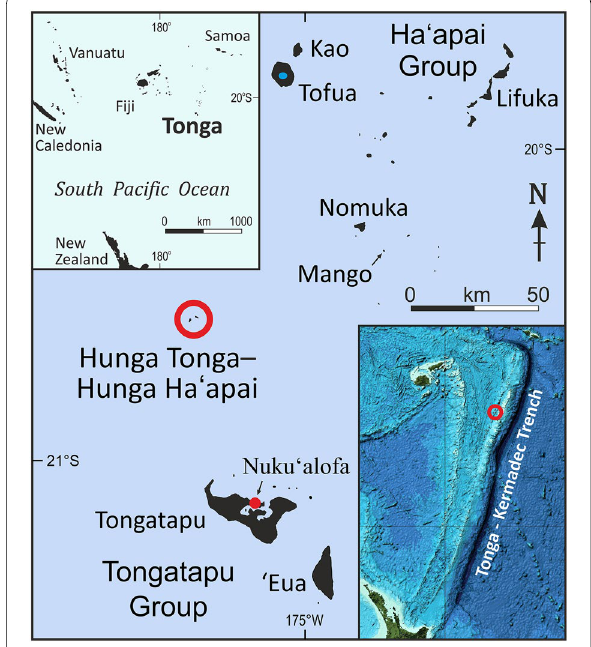
Fig. 1 Main map: location of the Hunga Tonga–Hunga Ha ʻ apai (HTHH) volcano in southern Tonga. Lower inset image: the Tonga-Kermadec submarine trench (subduction zone) in the southwest Pacific, showing the position of HTHH volcano on the Tofua Ridge to the immediate west of the trench. Source credit for bathymetry map: GEBCO